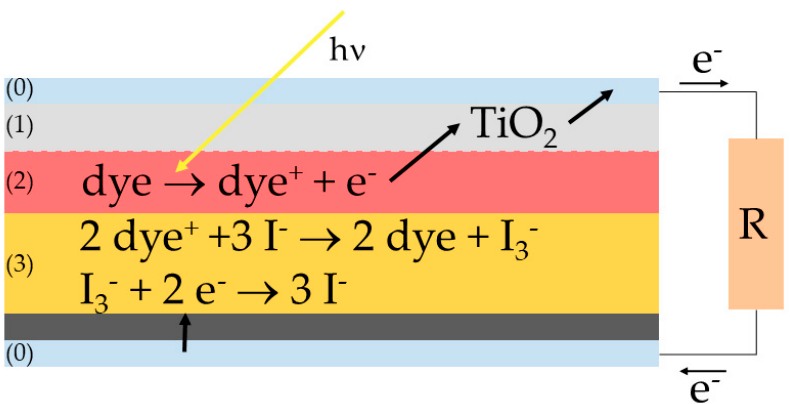
Figure 4. Schematic structure of a dye-sensitized solar cell.